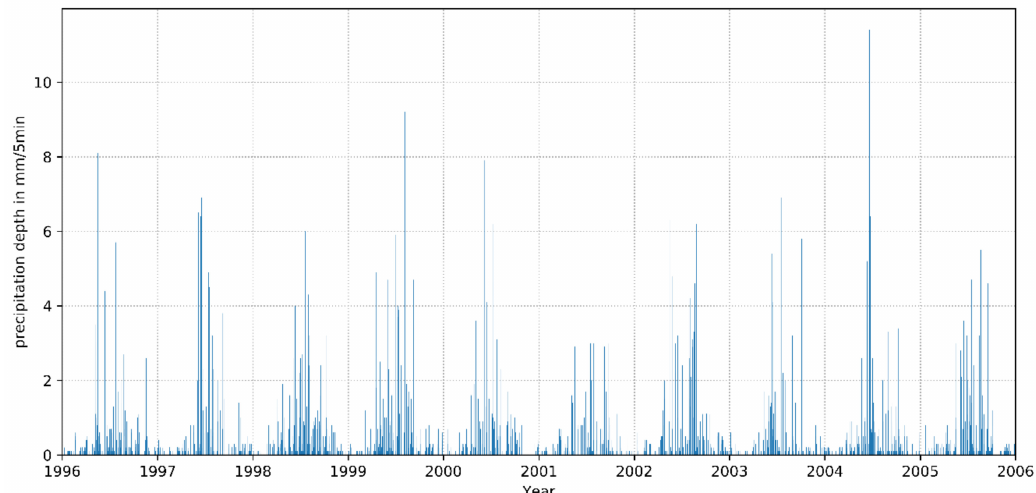
Figure 2. Precipitation time series used for the simulations; measured at Graz/Austria from 1996–2006.